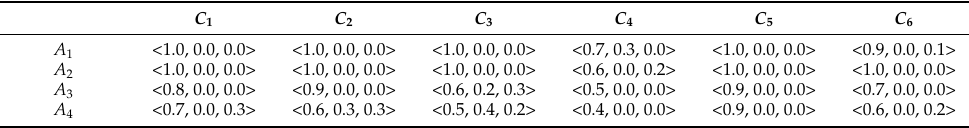
Table 4. The group evaluation matrix.